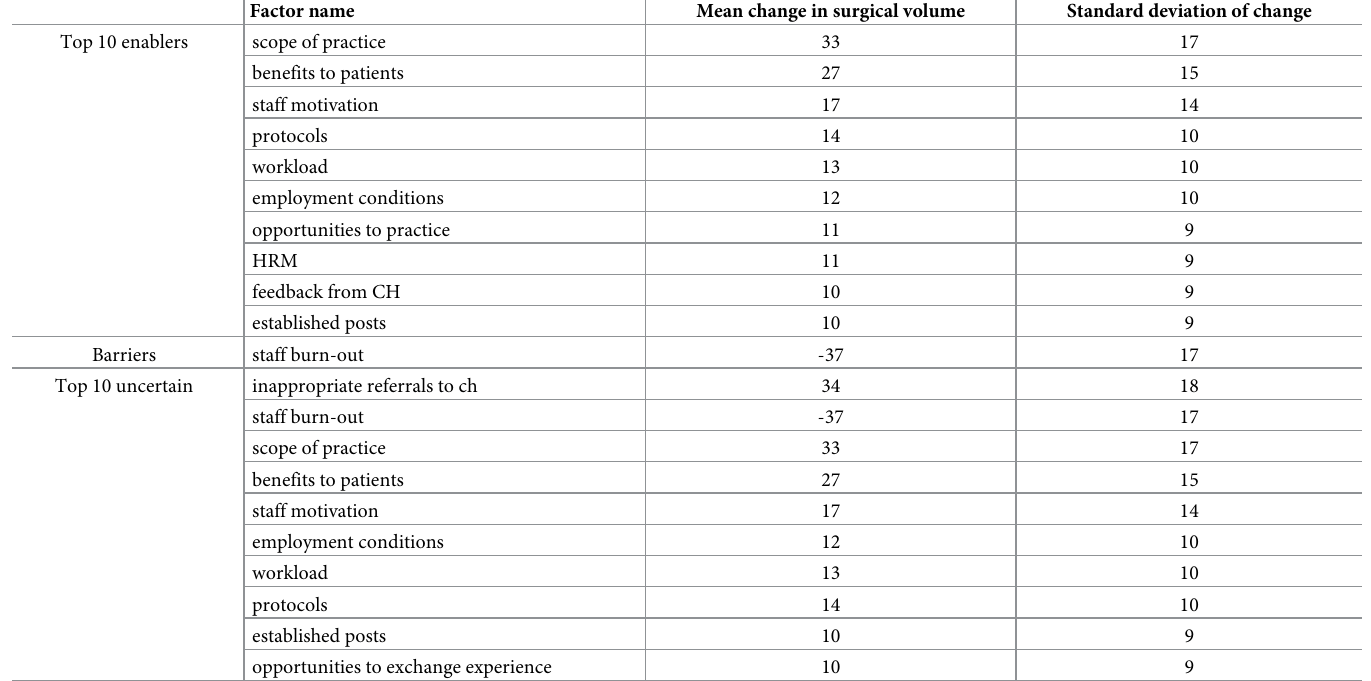
Table 5. Results of quantitative analysis of expected changes in volume of surgery at the district level using the MARVEL